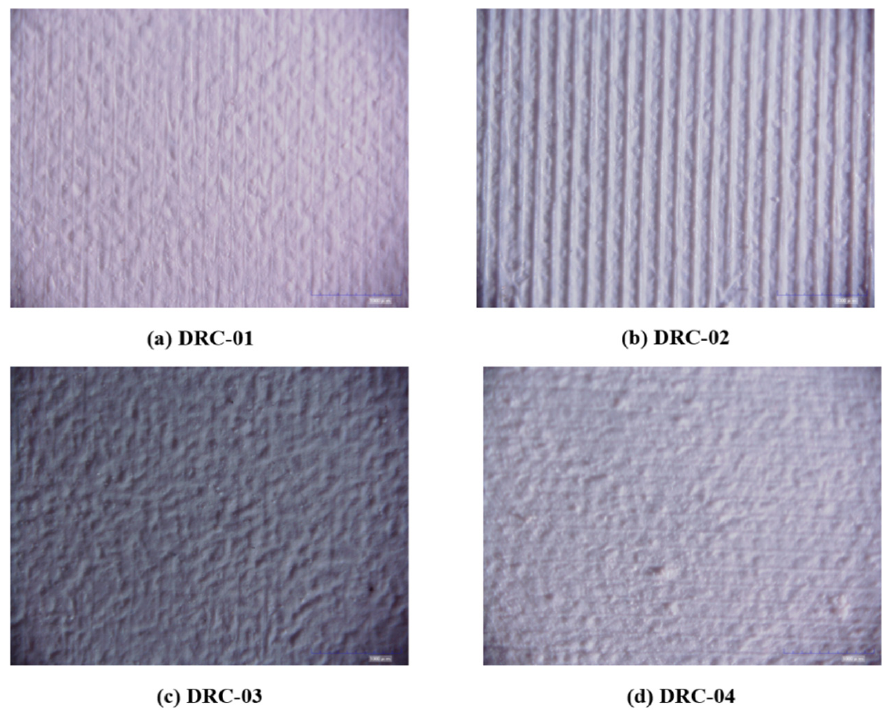
Figure 3. Two-dimensional structure of microgroove polyurethane coatings. Figure 5. Two-dimensional structure of microgroove polyurethane coatings. Figure 5. Two-dimensional structure of microgroove polyurethane coatings.